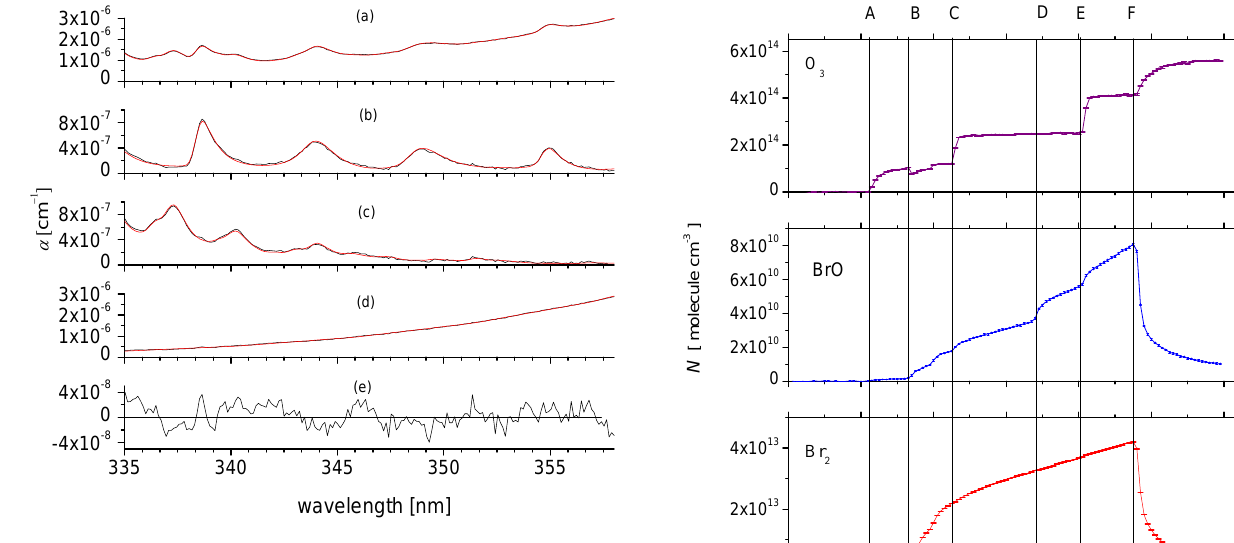
Fig. 9. Absorption and fitted spectra for the Br 2 , O 3 , and BrO sys- Figure 9. Absorption and fitted spectra for the Br 2 , O 3 , and BrO system. (a) Measured 2 tem. (a) Measured spectrum (black) and fitted result (red). The spectrum (black) and fitted result (red). The individual components of the spectrum are (b) 3 individual components of the spectrum are (b) BrO, (c) O 3 , and BrO, (c) O 3 , and (d) Br 2 . (e) Residual of the fit. 4 (d) Br 2 . (e) Residual of the fit.